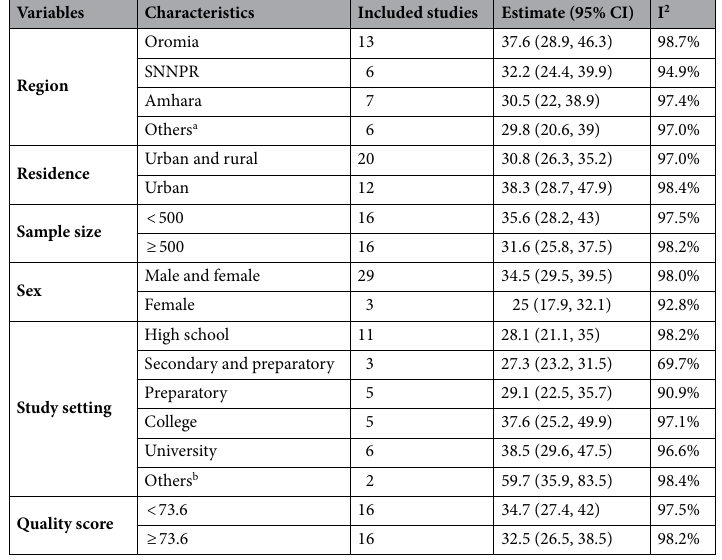
Table 2. Subgroup prevalence of pre-marital sex among students in Ethiopia, 2021 (n = 32). SNNPR-Southern Nation Nationalities and Peoples Region; a Tigray and Addis Ababa, b community and refugee camps.